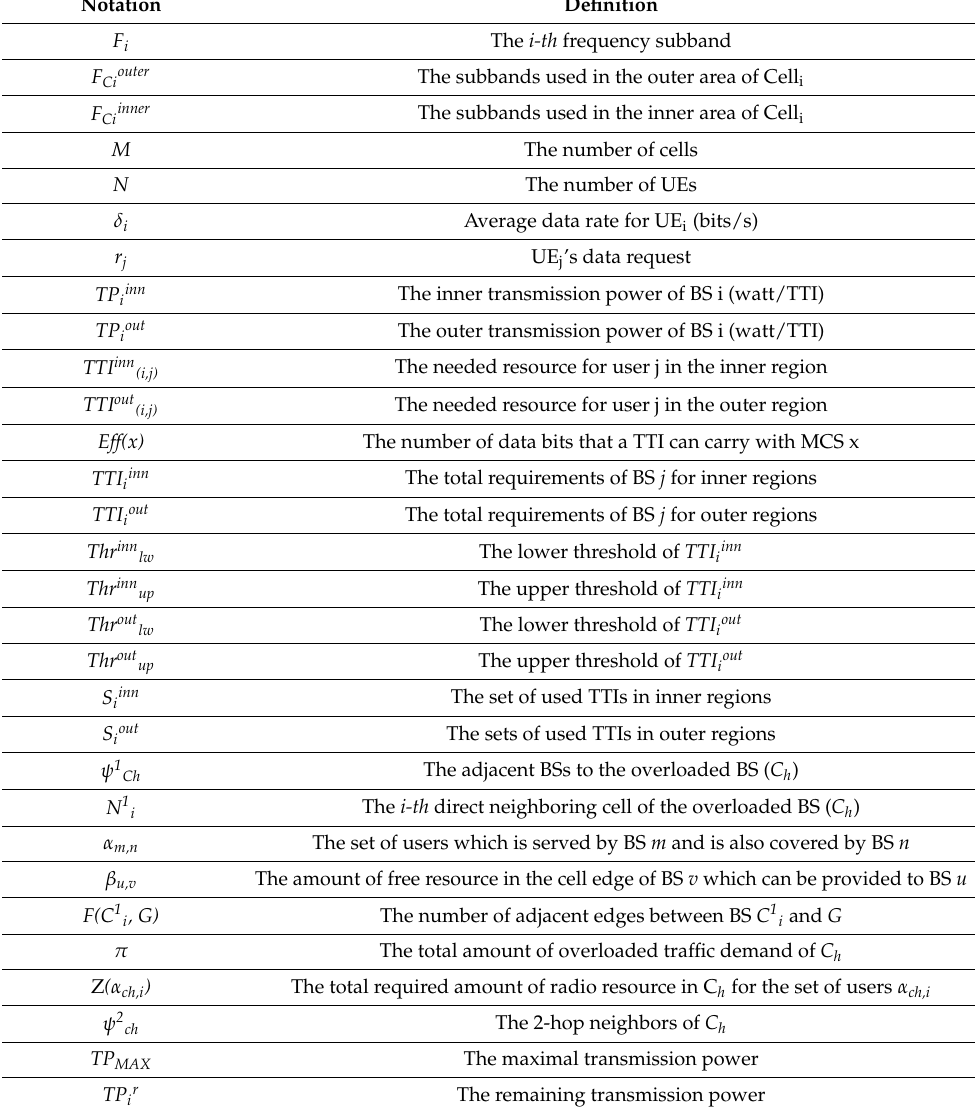
Table 2. Notations used in the